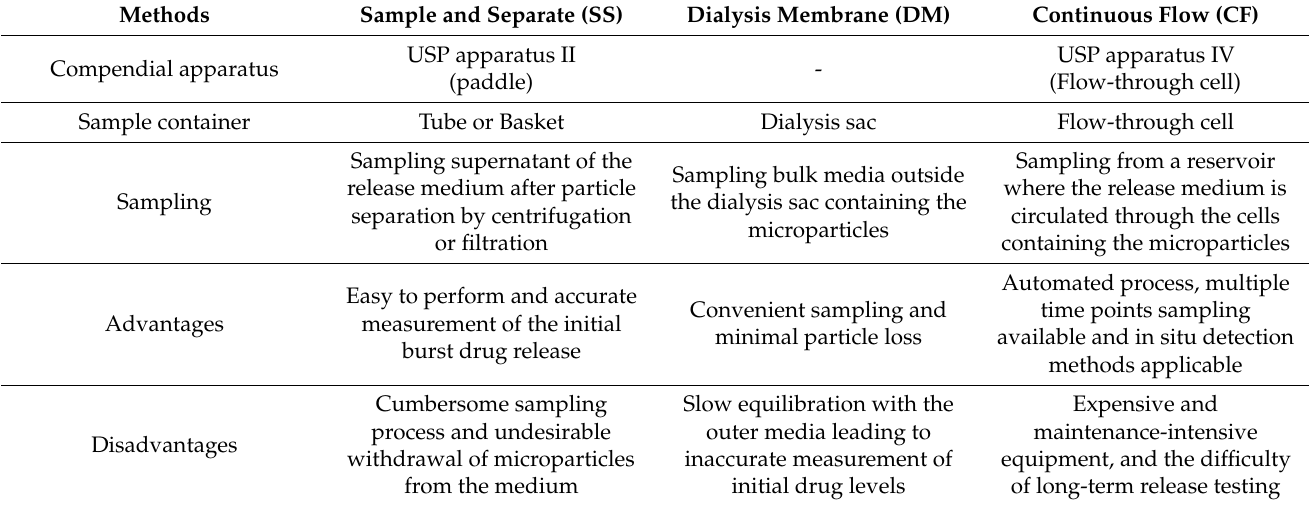
Table 2. Major characteristics of in vitro release testing methods for polymeric particulate